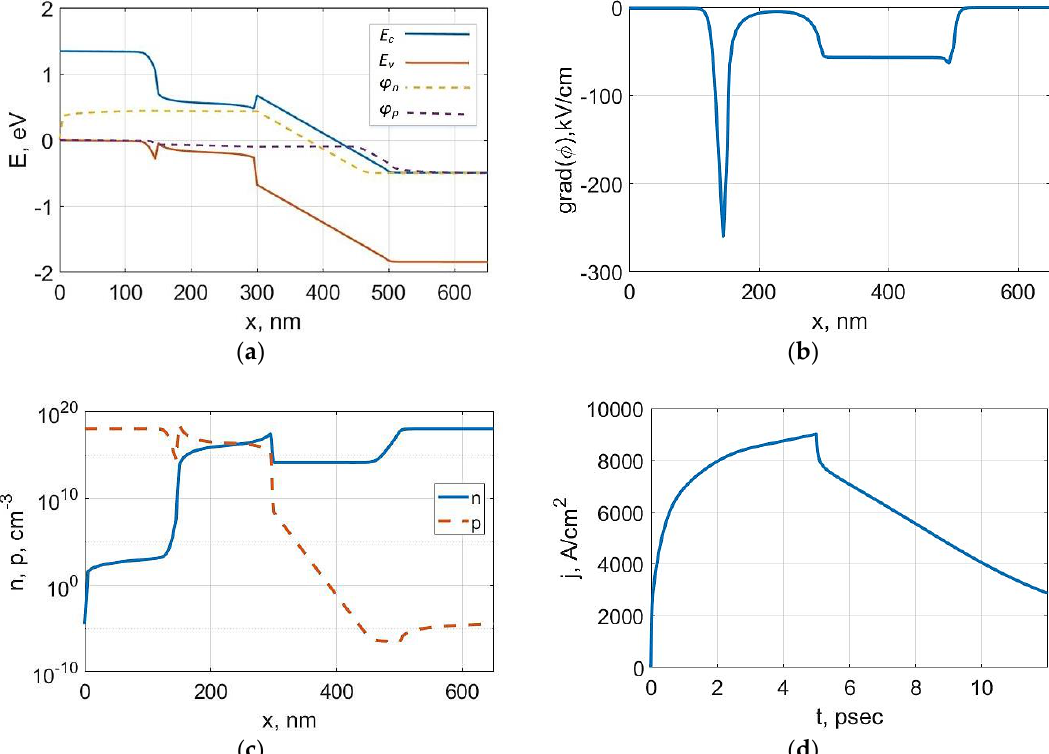
Figure 5. The results of the drift-diffusion numerical simulation of the InP/In 0.57 Ga 0.47 As uni-travelling- carrier (UTC) photodiode: the energy band diagram and quasi-Fermi levels ( a ), the spatial distributions of electric field intensity ( b ) and carrier densities ( c ); the dependence of current density on time in the case of illumination by 5-ps rectangular laser pulse ( d ).